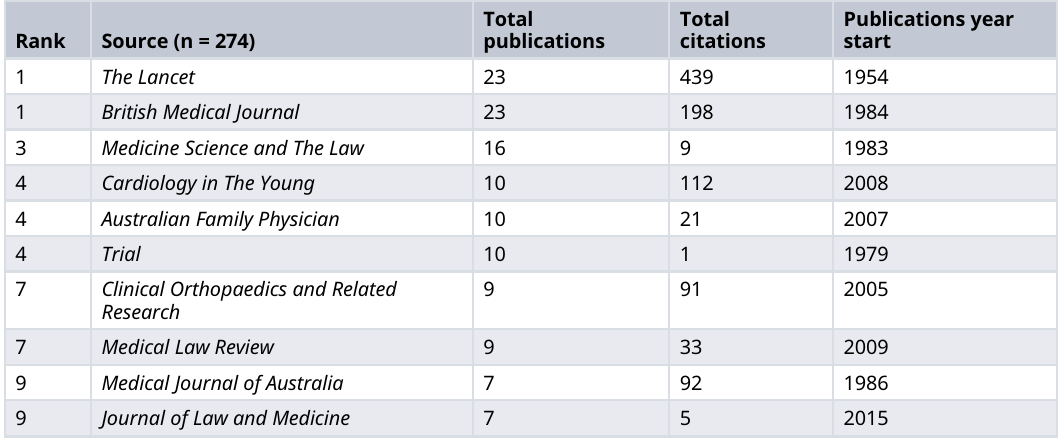
Table 6. Top ten sources of publications